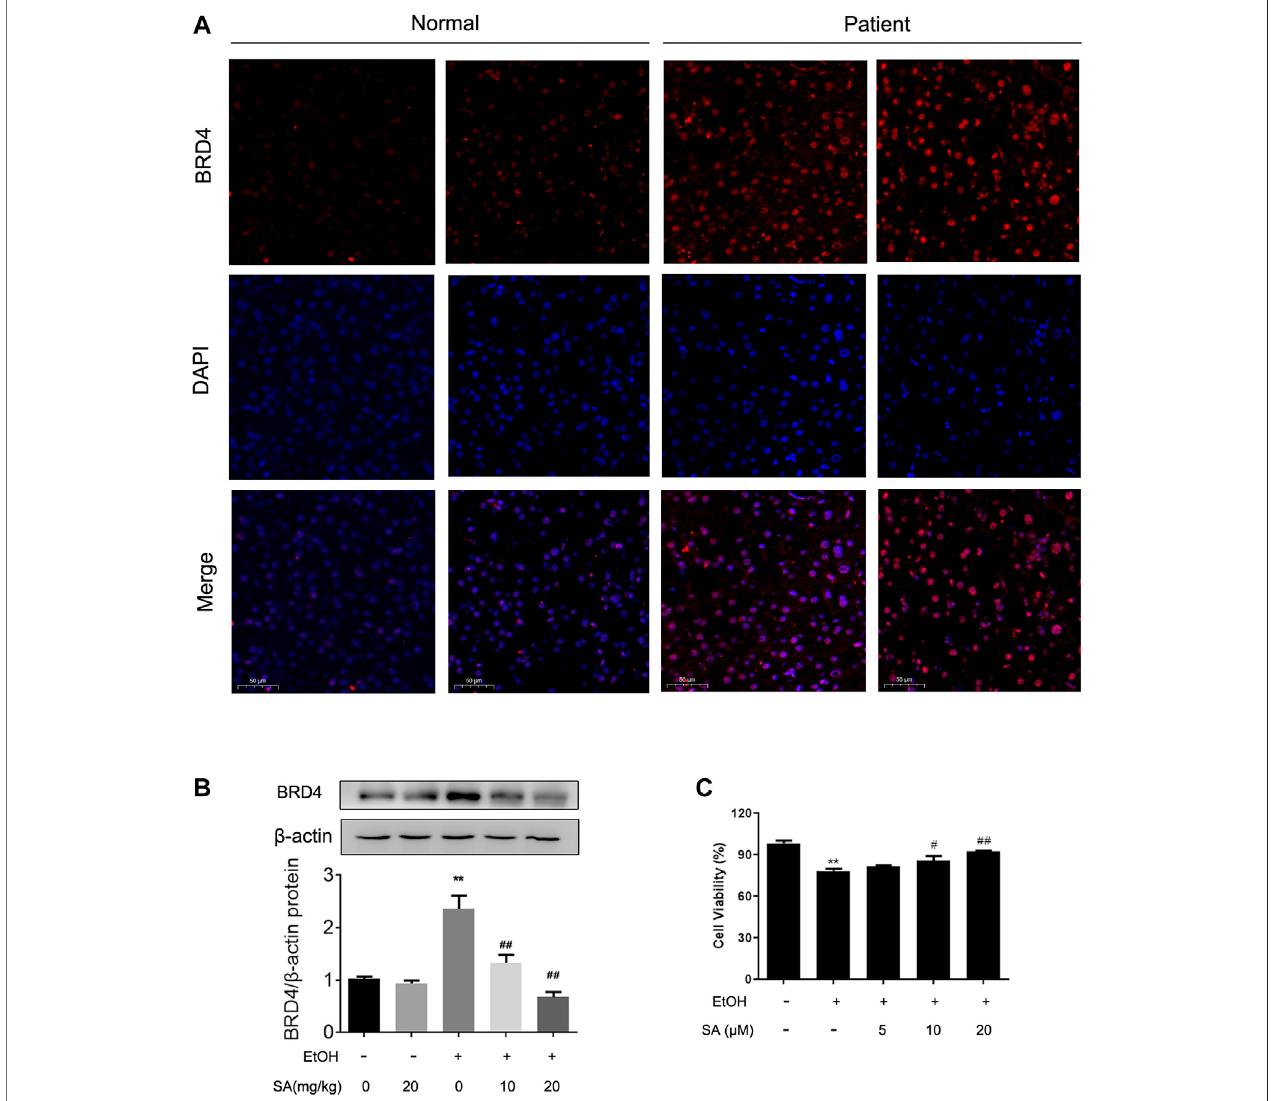
FIGURE 4 | Effects of SA on BRD4 protein level in vivo and in vitro (A) Immuno fl uorescence analysis of BRD4 protein expression in human ( × 200). Scale bar (cid:2) 50 μ m ( n (cid:2) 3). (B) Western blotting of hepatic BRD4 protein levels in mice ( n (cid:2) 3). ** p < 0.01 vs the ND group; ## p < 0.01 vs the ALD group. (C) AML-12 cells were pretreated with 5, 10, or 20 μ M SA for 6 h before exposure to EtOH (100 mM) for another 24 h. The viable cells were determined by the CCK8 assay. ** p < 0.01 vs the control group; # p < 0.05, ## p < 0.01 vs the EtOH group.